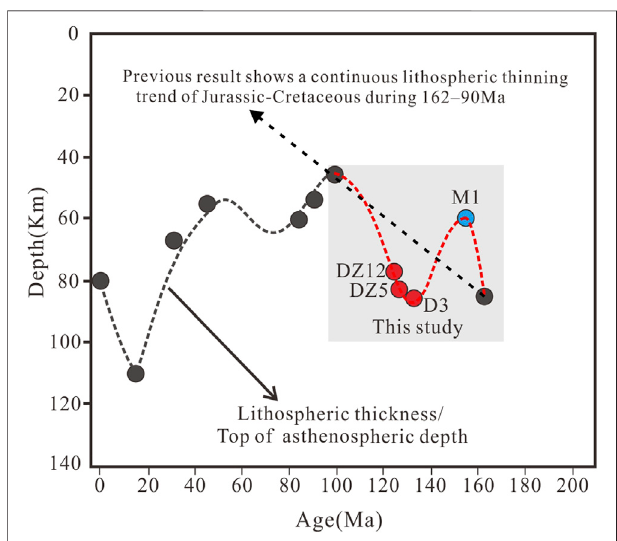
FIGURE 12 | Variation in lithospheric thickness in Northeast China (200 Ma-0 Ma). 170 Ma from Lu et al. (1996) and Huang et al. (2021); 100 Ma from Xu et al. (1994); 88 Ma from Wang et al. (2009); 92 Ma, 31 Ma, and 15 Ma from Zhang et al. (2006); 45 Ma from Zhou (2006); 0 Ma from Wang et al.